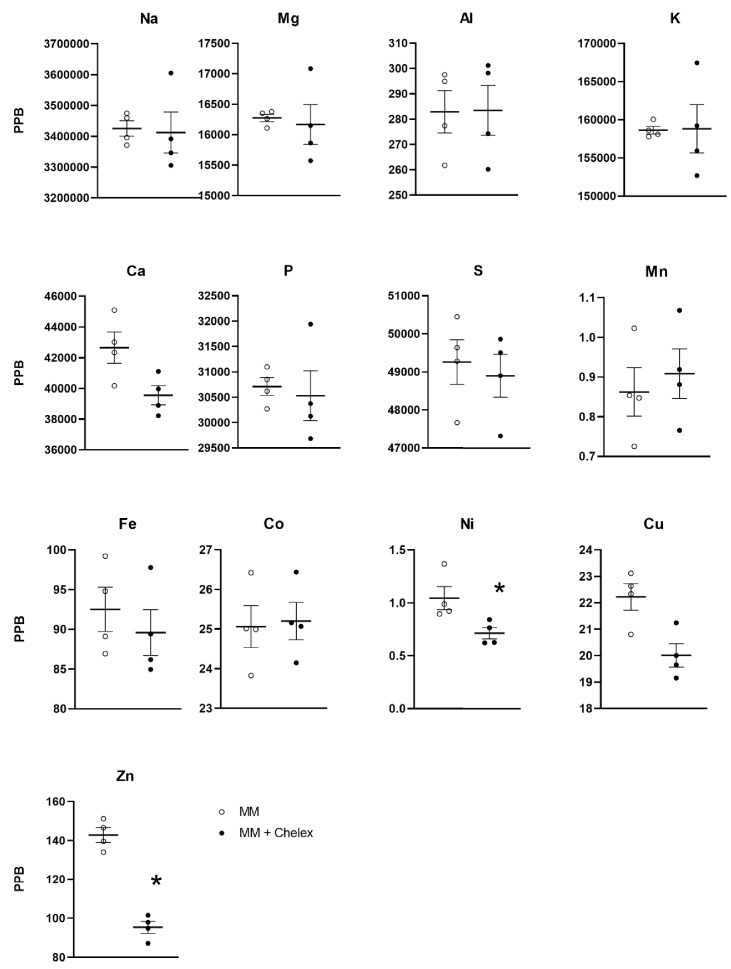
Total elemental content in minimal medium with and without Chelex 100 treatment.ICP-MS analysis was used to measure elemental content in minimal medium containing 1.5% horse serum. Components of MM (horse serum and insulin) were treated with Chelex 100 to remove additional Zn (MM+Chelex). n = 4 replicates per condition. Black bars indicate mean and SEM is depicted with brackets. While Cu and Ca were slightly lower in Chelex-treated medium, the differences were not statistically significant. The difference for Zn and Ni was statistically significant, where * indicates p<0.05 with paired t-test. For Zn, p=0.0059 and for Ni, p=0.0276.Figure 1—figure supplement 1—source data 1.ICP-MS data for total elemental content in minimal medium with and without Chelex-100.